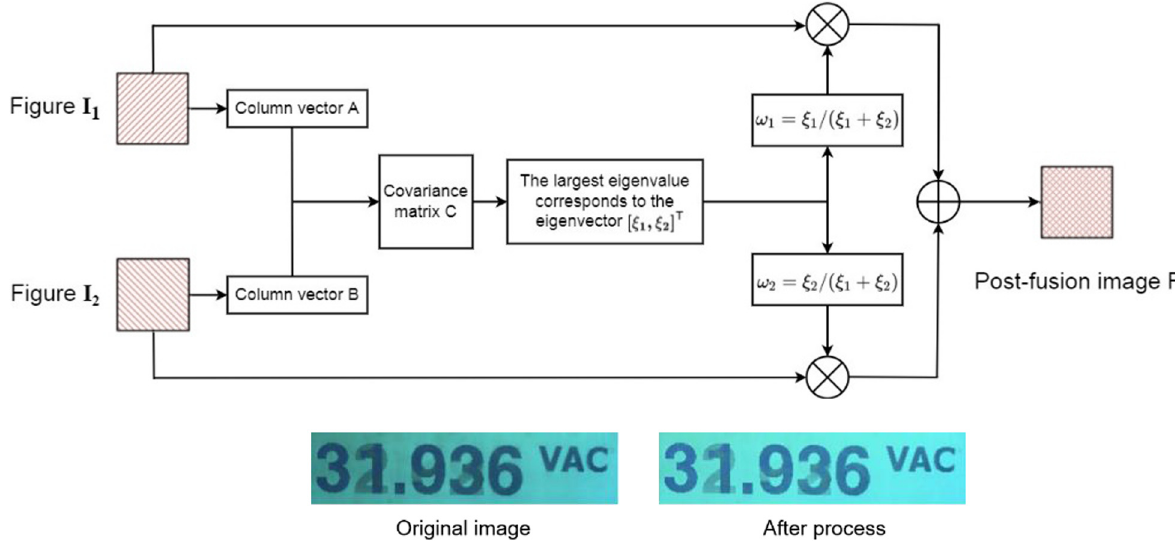
Figure 3: Image fusion based on PCA.